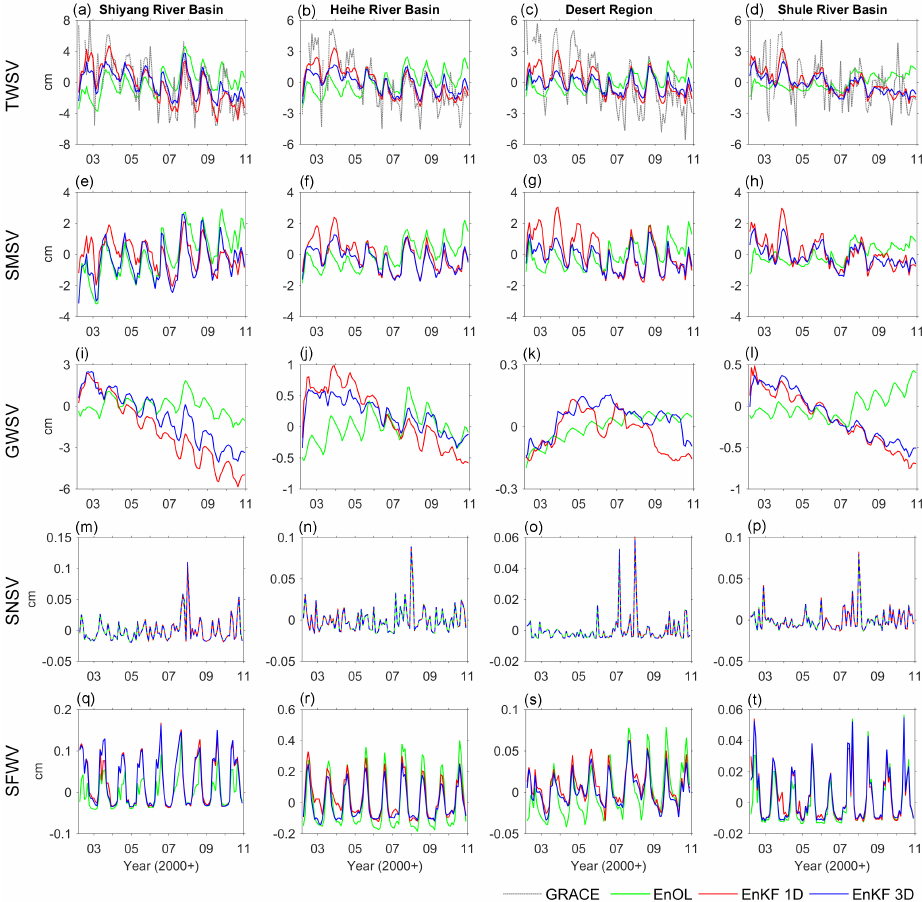
Figure 10. Monthly TWSV, SMSV, GWSV, snow water storage variation (SNSV), and surface water storage variation (SFWV) estimated between April 2002 and December 2010 from the EnOL, EnKF 1D, EnKF 3D, and GRACE observations over four basins.